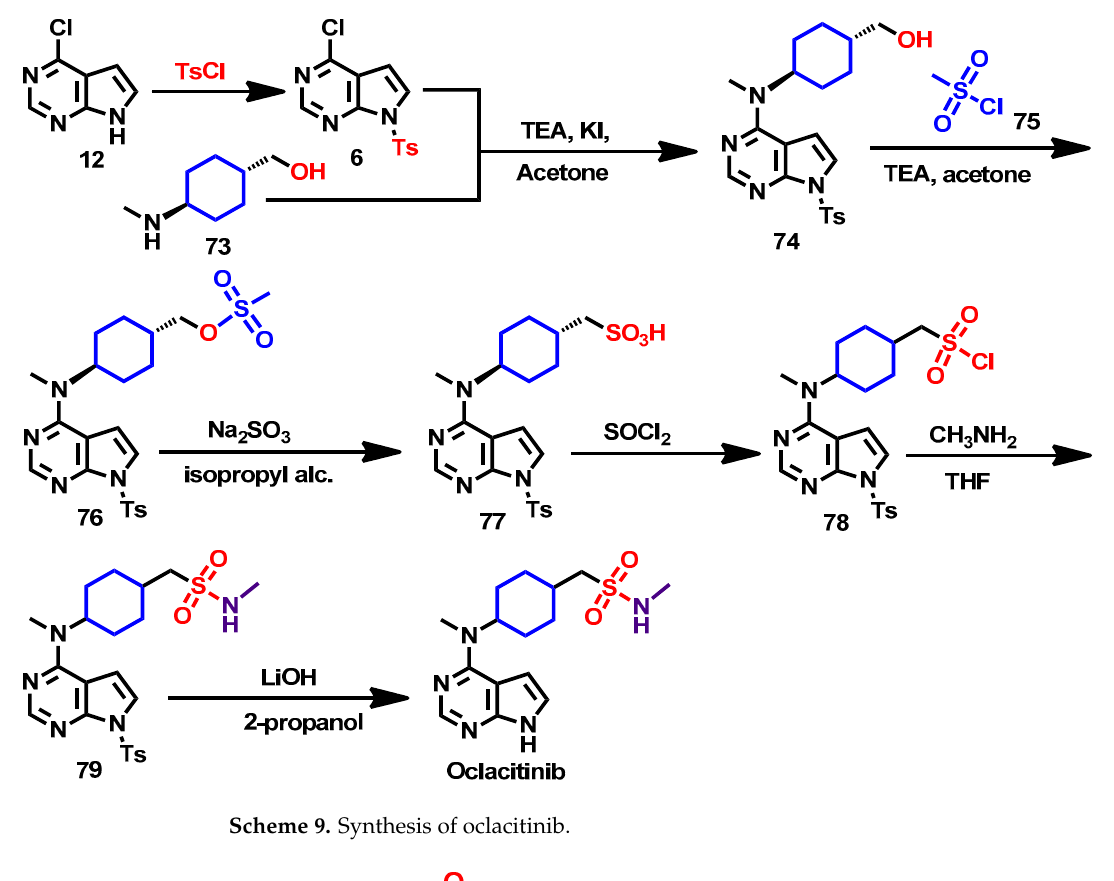
Figure 37. Chemical structure/name/synonyms of oclacitinib.